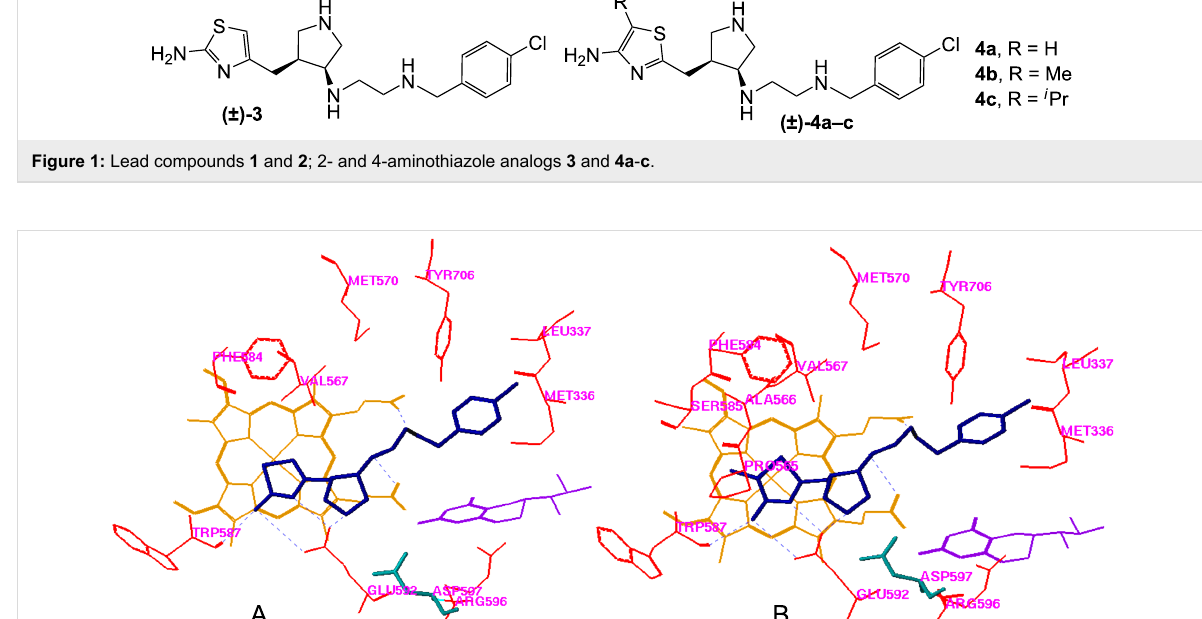
Figure 2: A: The docking conformation of 3 in the active site of rat nNOS; B: The docking conformation of 4b in the active site of rat nNOS. Cofactors heme and H 4 B are shown in orange and purple,